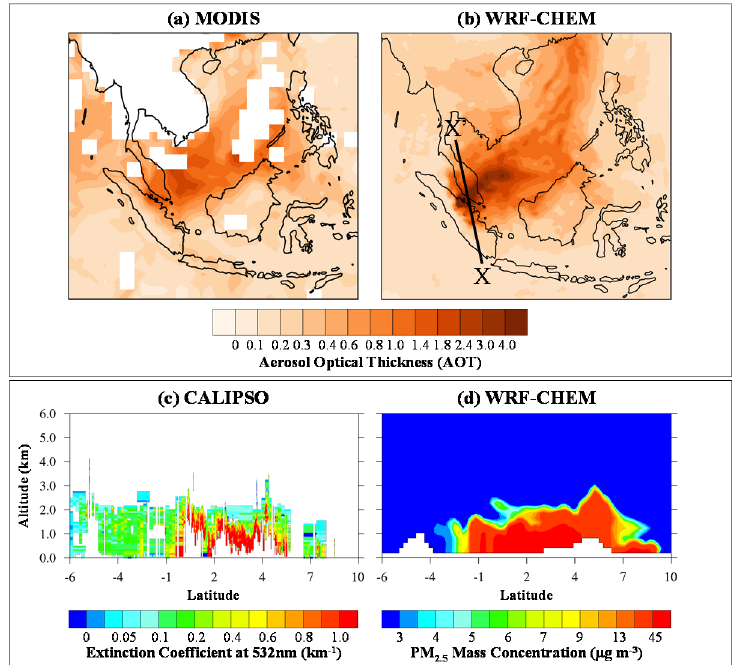
Figure 8. Aerosol optical thickness (AOT) at 550 nm, from 20 to 25 June 2013 over the MC from ( a ) MODIS Terra and ( b ) WRF ‐ Chem simulations. Also, the comparison of ( c ) CALIOP ‐ derived vertical profile of extinction coefficient at 532 nm with ( d ) the WRF ‐ Chem simulated vertical profile of PM 2.5 smoke concentration along the corresponding portion of the CALIPSO ground track on 24 June 2013. The ground track is indicated by the line XX’ on ( b ).